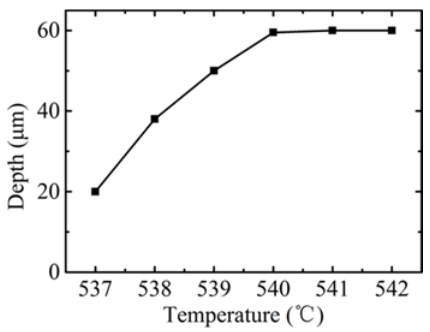
Figure 7. The influence of temperature on depth.